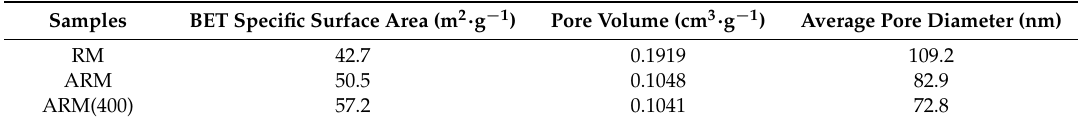
Table 2. BET surface areas, pore volumes and average pore diameter of RM, ARM and ARM(400). ARM( t ), where t refers to the calcining temperature.